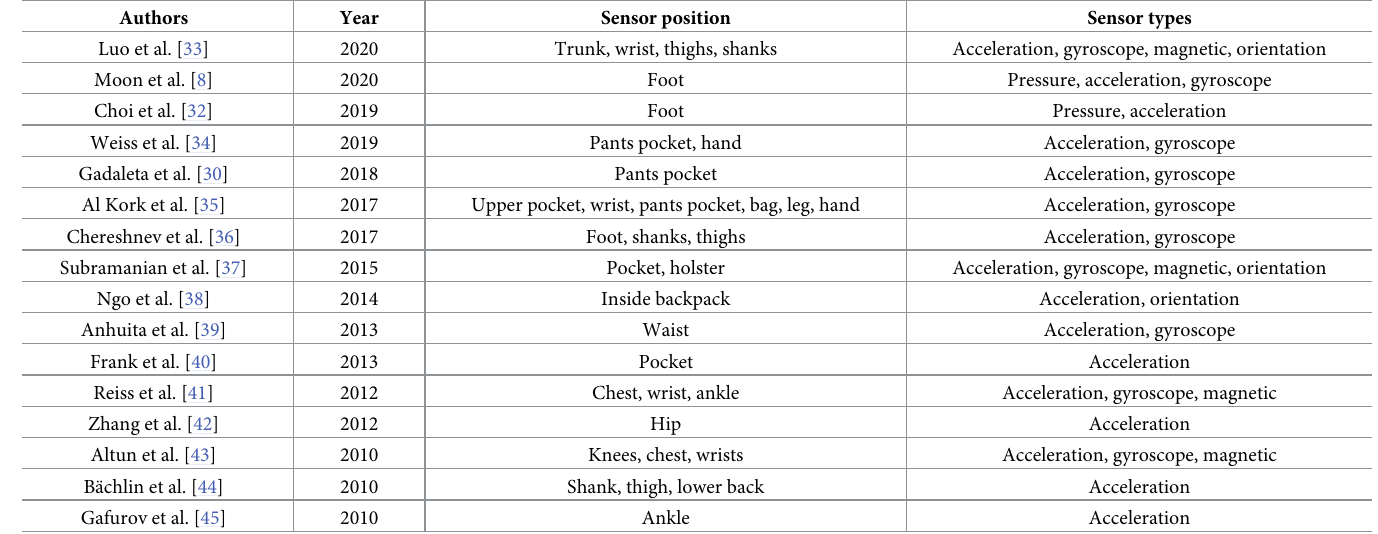
Table 1. List of the related work on gait